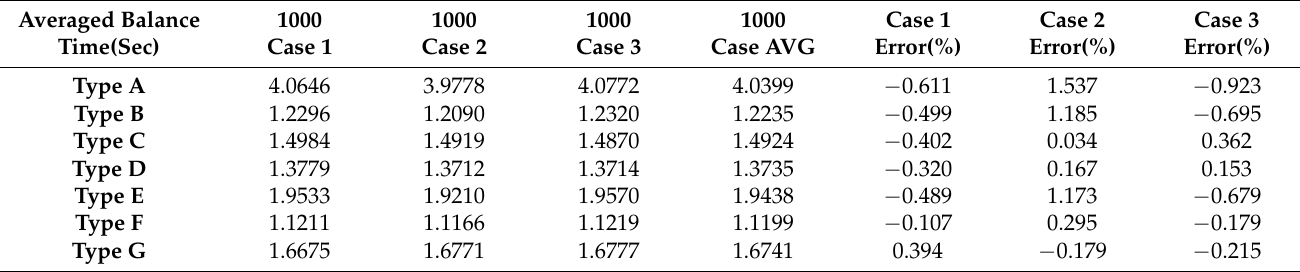
Table 5. Average balancing times of 8 battery cells using different SC-based BEs.